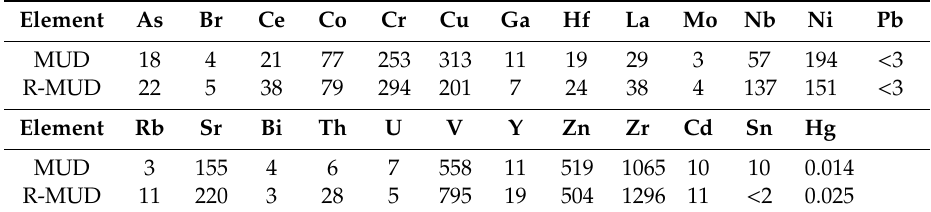
Table 3. Concentration (ppm) of trace elements in sample of waste before (MUD) and after rinsing